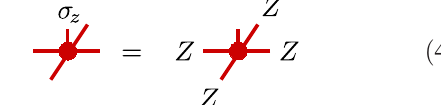
FIG. 11. (a) Mapping from the PEPS tensor for the toric code in a field in the dual representation in Fig. 2(e) (top) to the Ising model. First, the virtual degrees of freedom (color variables) are copied to physical degrees of freedom, which become the Ising degrees of freedom (middle; three meeting lines correspond to a delta tensor in the Ising = j(cid:5)i basis). Then, the physical degrees of freedom of the toric code are disentangled, e.g., by using controlled- NOT operations in the j(cid:5)i basis, controlled by the Ising degrees of freedom (as indicated by the arrows in the middle panel). The disentangled degrees of freedom can then be discarded, resulting in a tensor network for the Ising model (bottom). This can be seen as the reverse of a gauging trans- formation. (b) Effect of a string of Z operators in the dual representation: Z operators flip the color label of a plaquette, giving rise to a domain wall in the coloring and, thus, broken dual loops (green line) at the end point of the Z